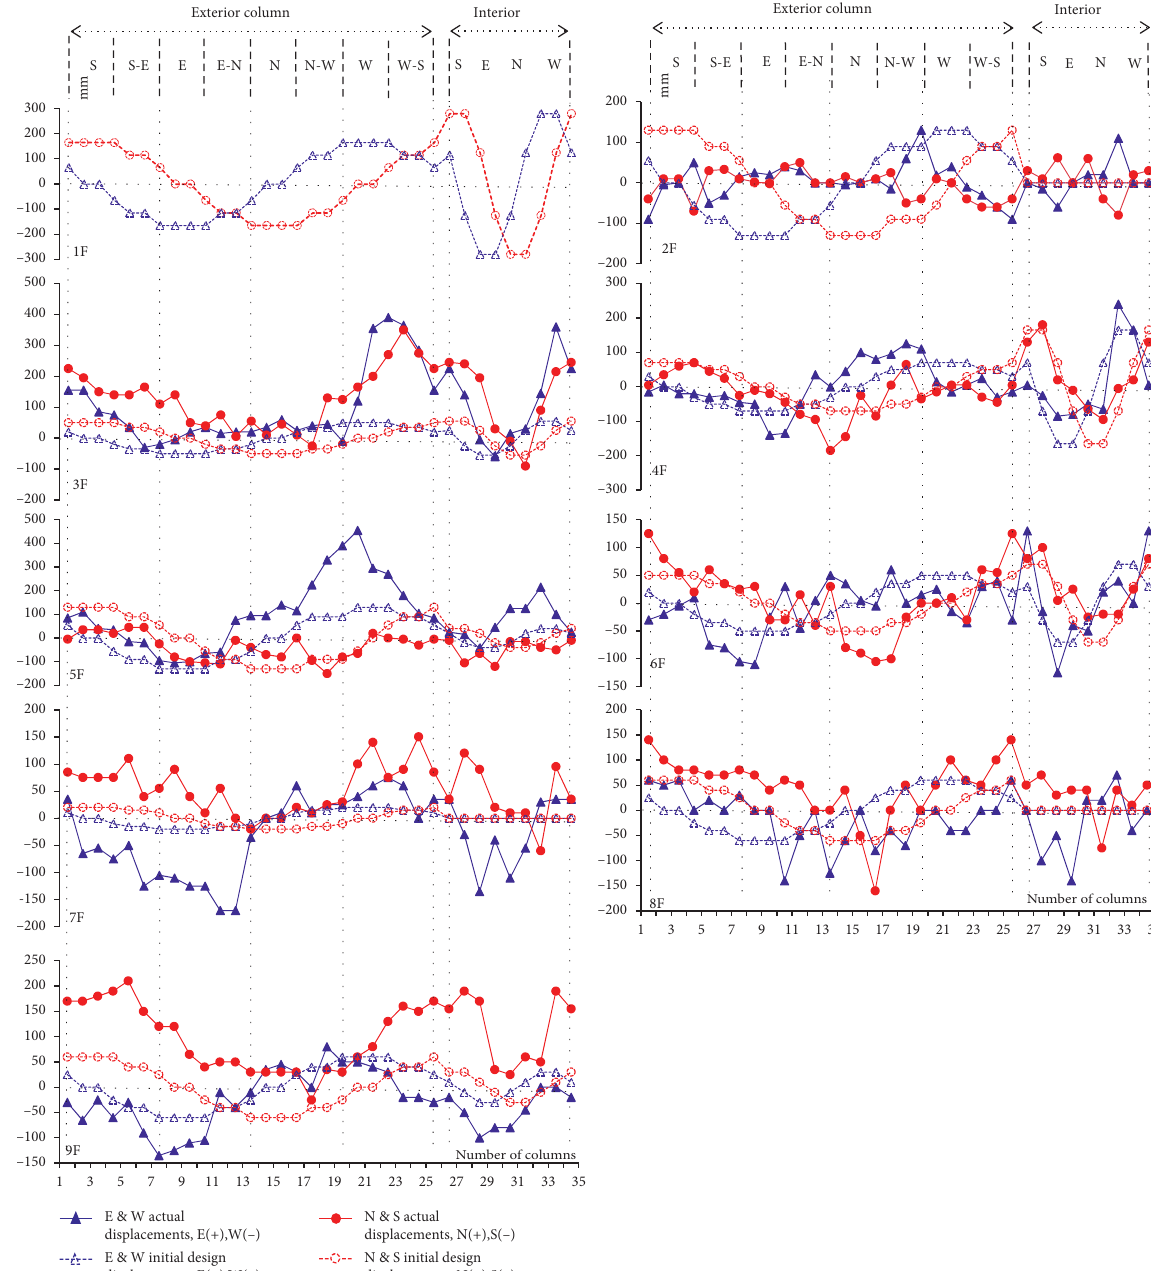
Figure 8: Horizontal displacements at the column